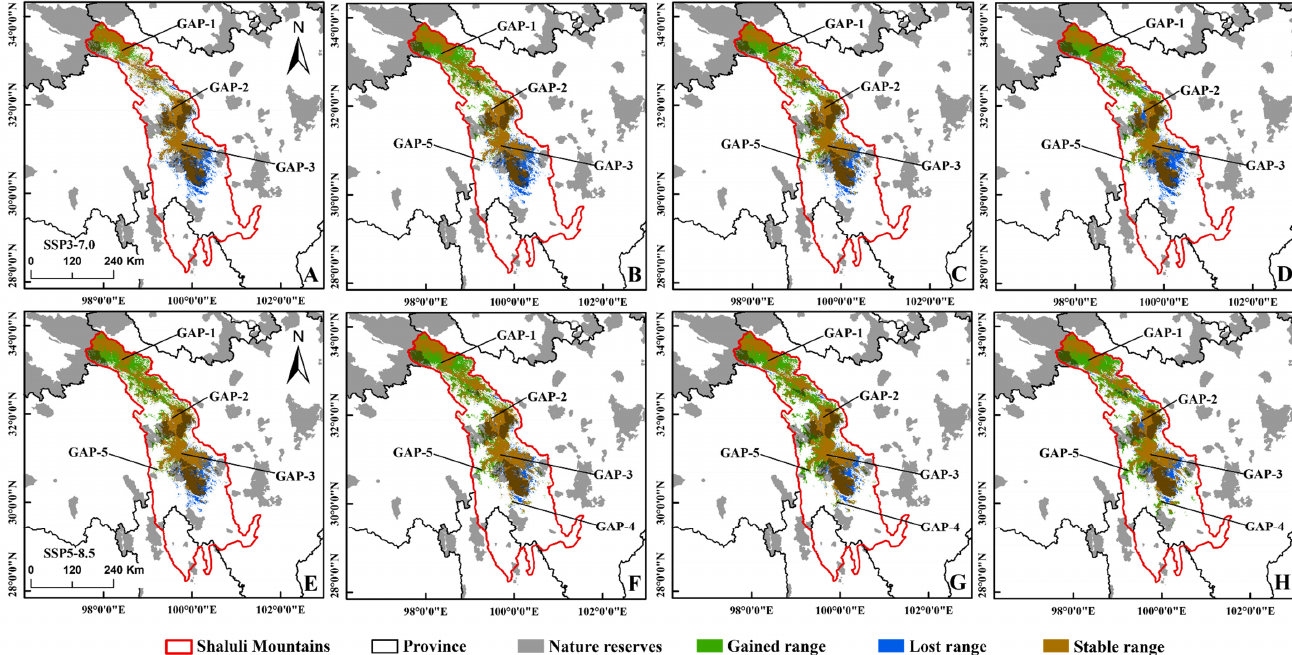
Figure 4. The potential distribution of suitable areas for the black-necked crane under the climatic conditions of shared socio-economic pathway 3–7.0 (top), 5–5.8 (bottom) during different periods of the 21st century: ( A , E ) 2021–2040, ( B , F ) 2041–2060, ( C , G ) 2061–2080, ( D , H ) 2081–2100.